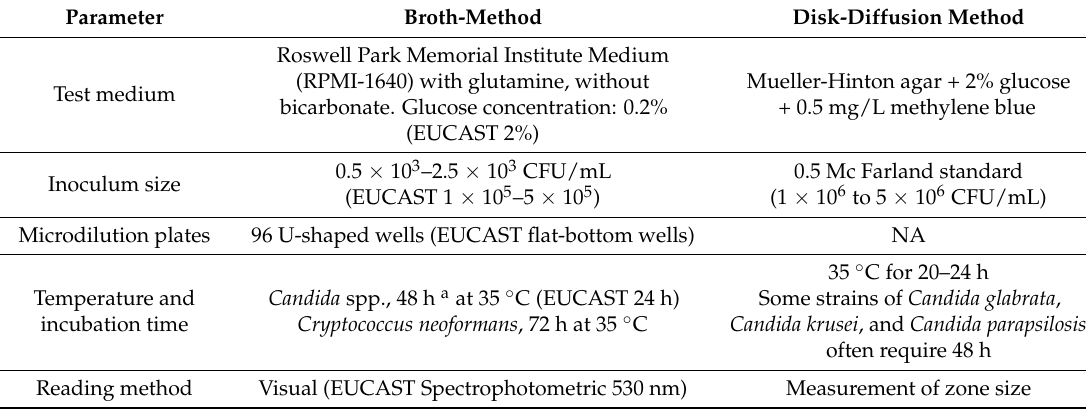
Table 1. Main parameters for the performance of the Clinical and Laboratory Standards Institute (CLSI) broth methods (M27-A3 and M27-S4 documents) (with European Committee on Antibiotic Susceptibility Testing (EUCAST) modifications) and disk diffusion method (M44-A and